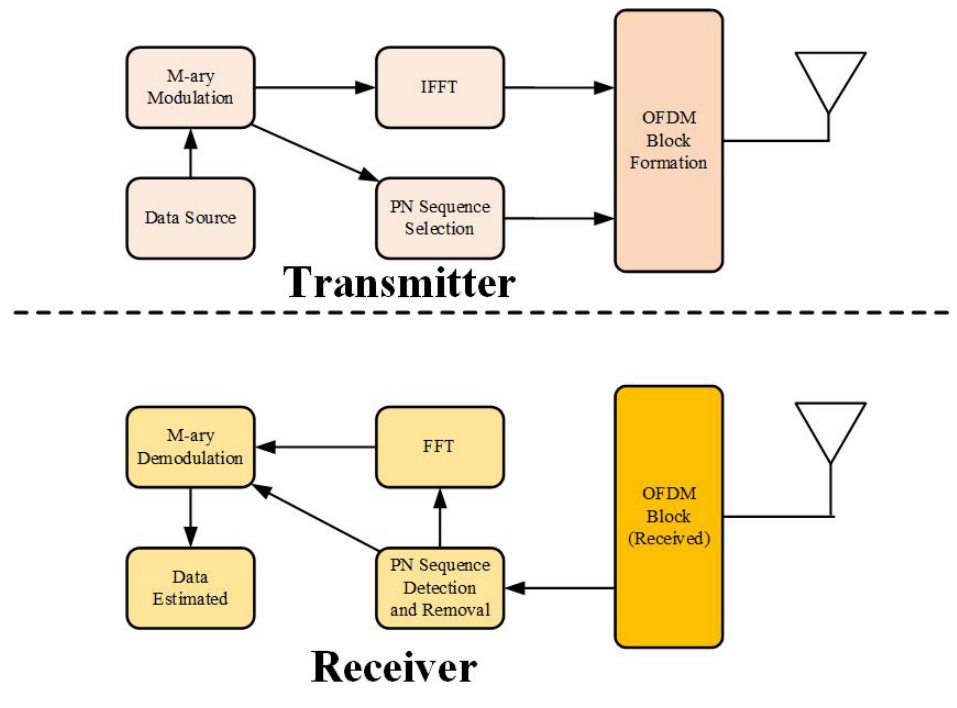
Figure 1. Proposed model for OFDM system.